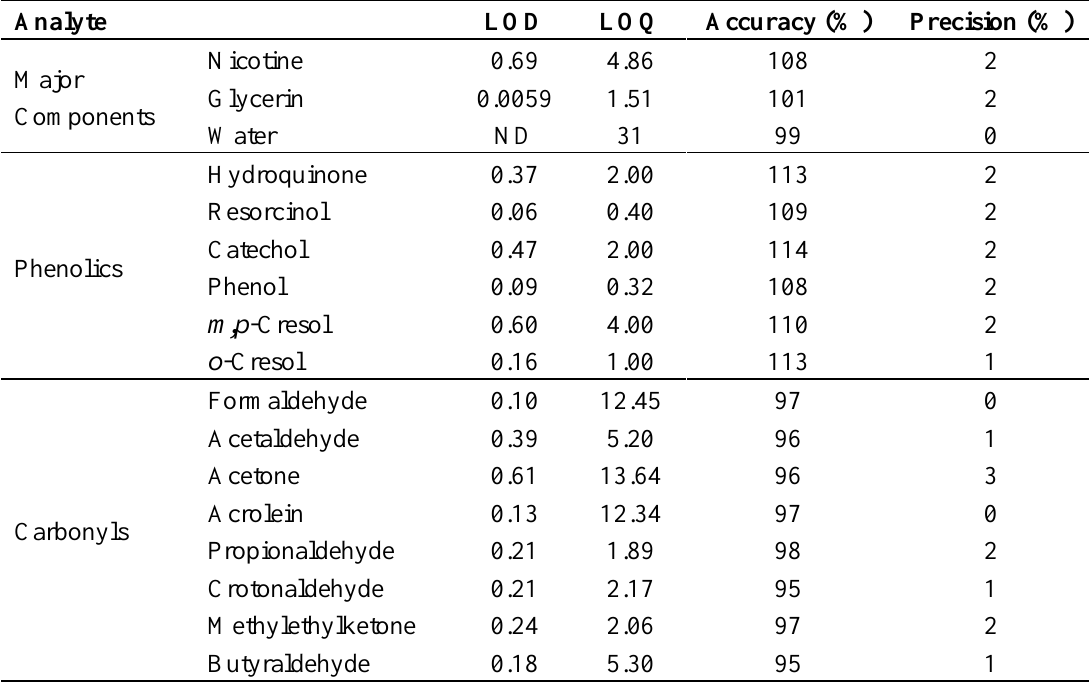
Table 2. Exhaled aerosol analysis capabilities for major components, phenolics and carbonyls in e-cigarette